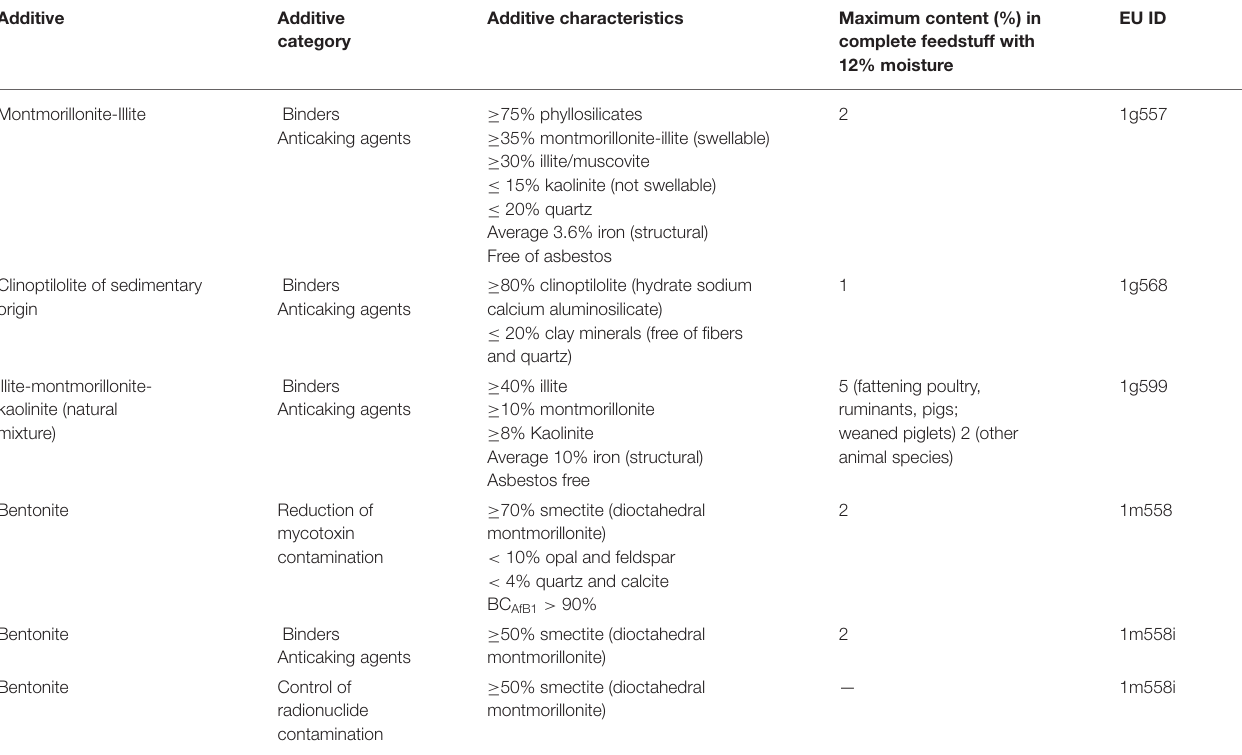
TABLE 1 | Characteristics of the clay minerals authorized by the European Commission as feed additives (5). Additive Additive